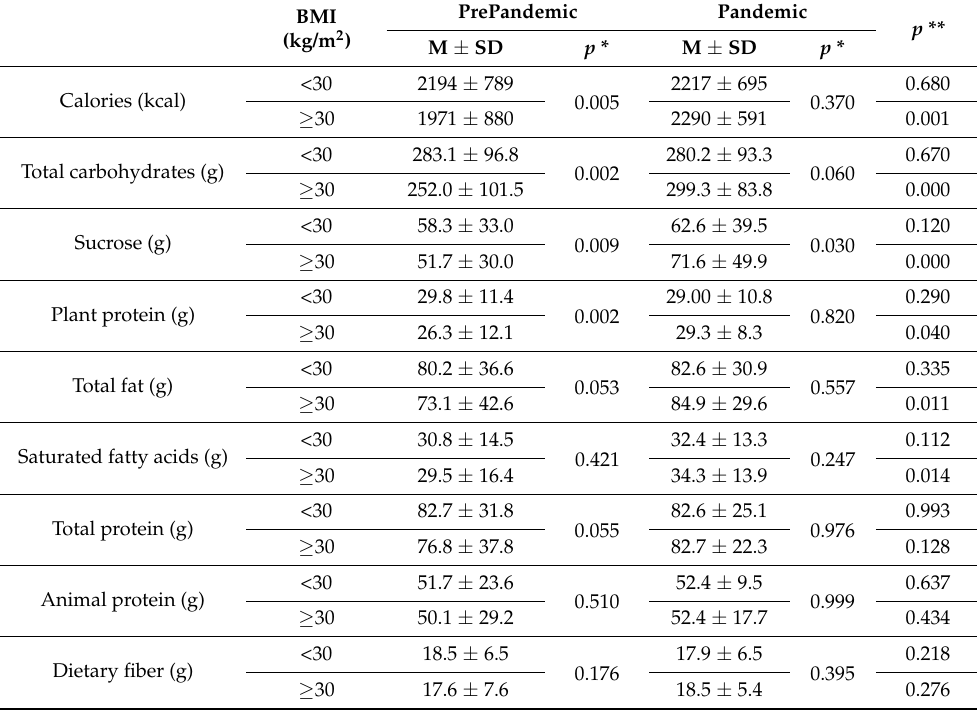
Table 9. Daily calorie (kcal/day) and macronutrient (g/day) intake in respondents’